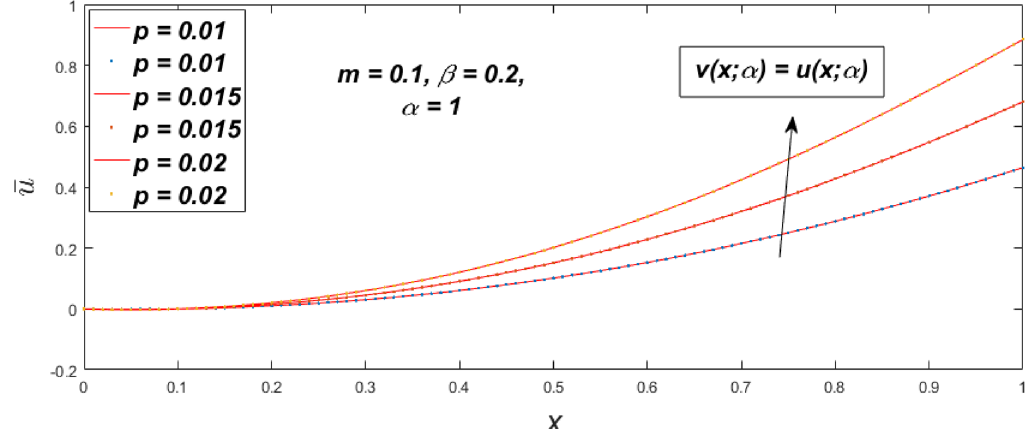
Figure 39. Fuzzy velocity for the impact of